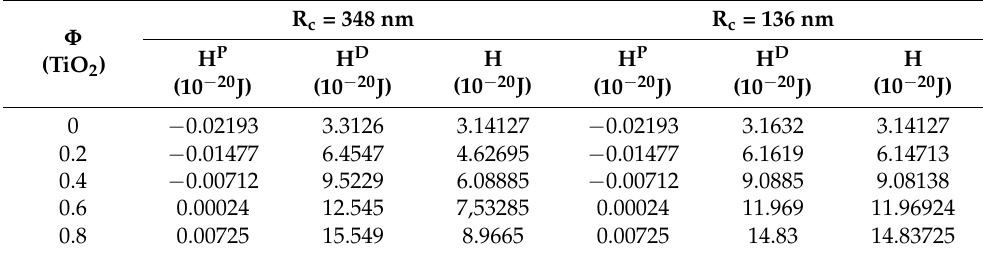
Table 3. The nonretarded Hamaker constants as a function of the volume fraction Φ of NPs for